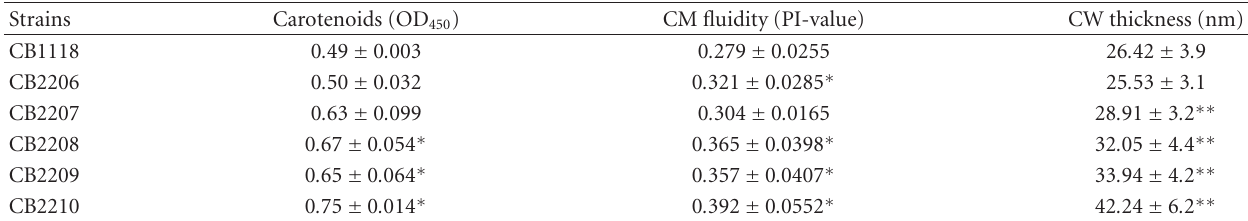
Table 4: Quantification of CM carotenoid pigment, CM fluidity and CW thickness.